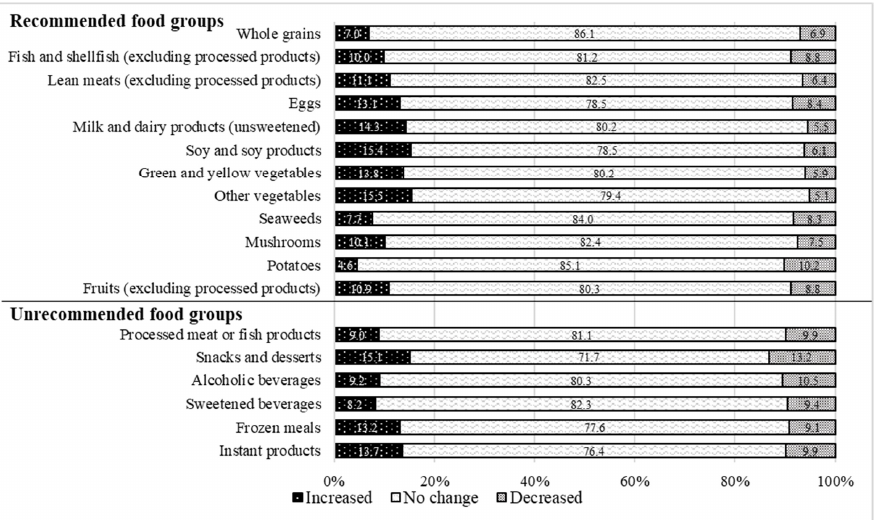
Figure 1. Percentage of participants reporting increased, no change, or decreased frequency of in- take of 18 food groups (12 recommended and 6 unrecommended) compared to before COVID-19.